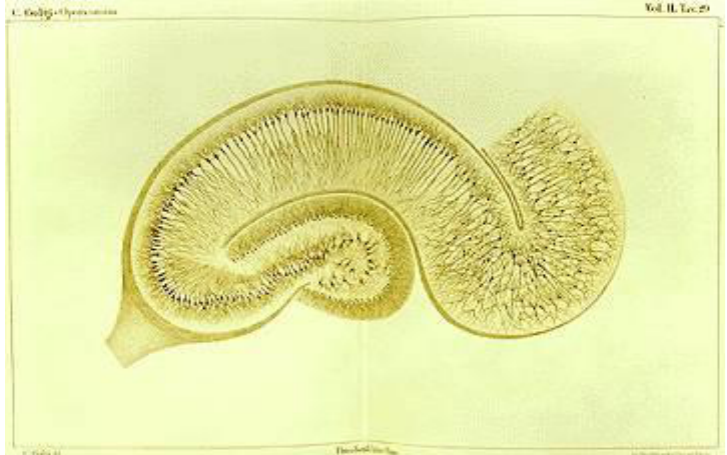
Figure 2. Figure showing microscopic drawing of hippocampus stained with Black Reactio. His- tological plate prepared by Camilo Golgi. Image in public domain and free from copyright issues. Source of Image: Wikimedia Commons.